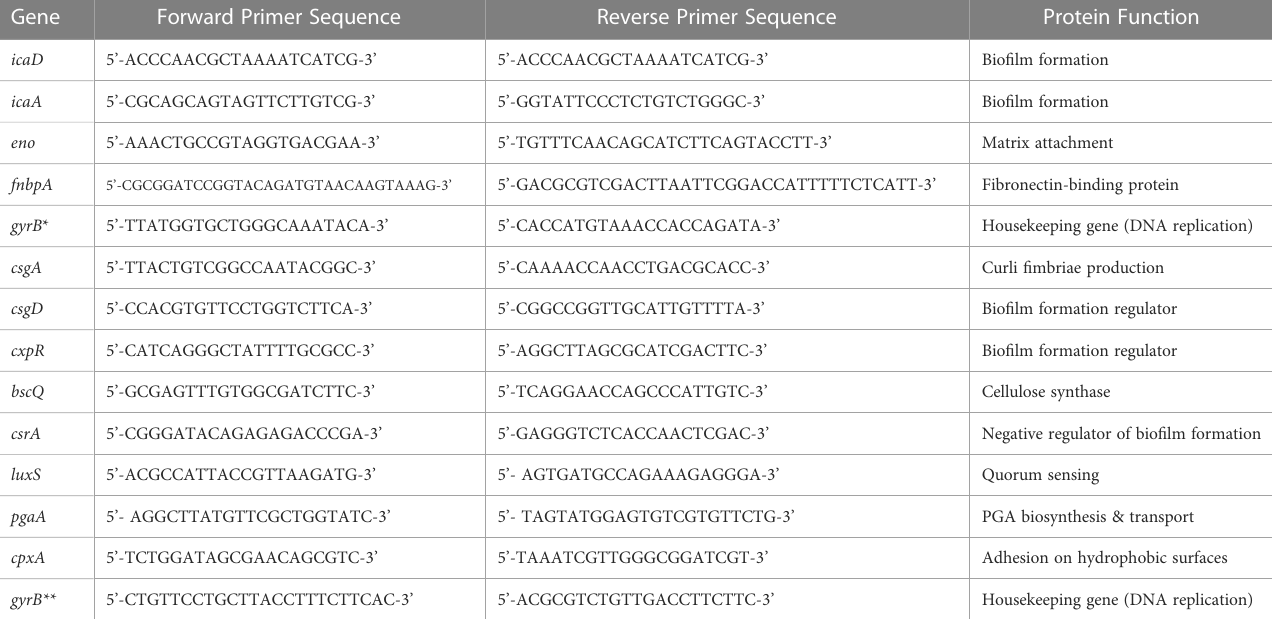
TABLE 1 Primers used for quantitative real-time PCR